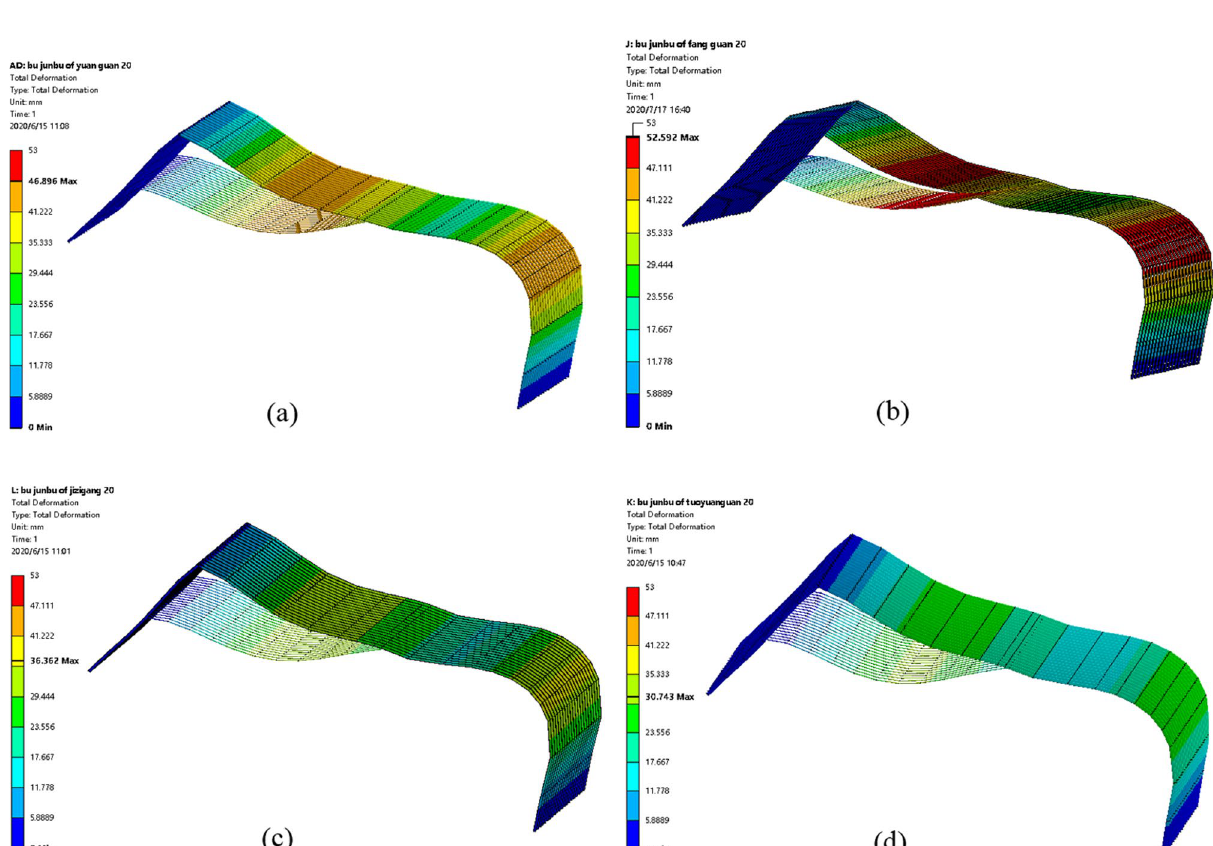
Figure 12. Skeleton shape variations under non-uniform snow load condition: ( a ) round tube; ( b ) square tube; ( c ) Ω tube; ( d ) elliptic